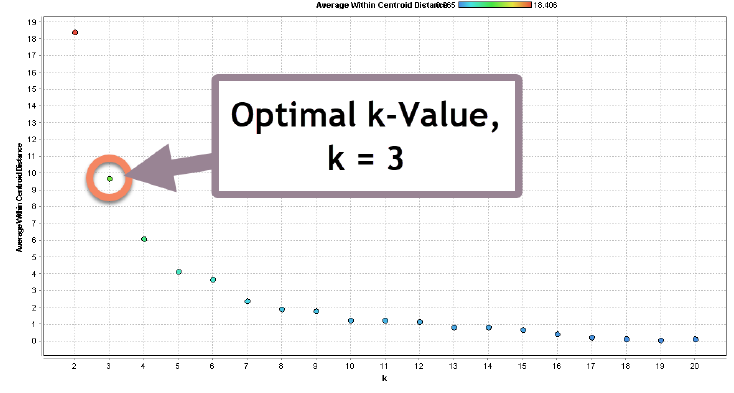
The appropriate number of clusters of course 221203 (2020) Table 7. Average within centroid distance (ACD) results for course 221203 (2020)